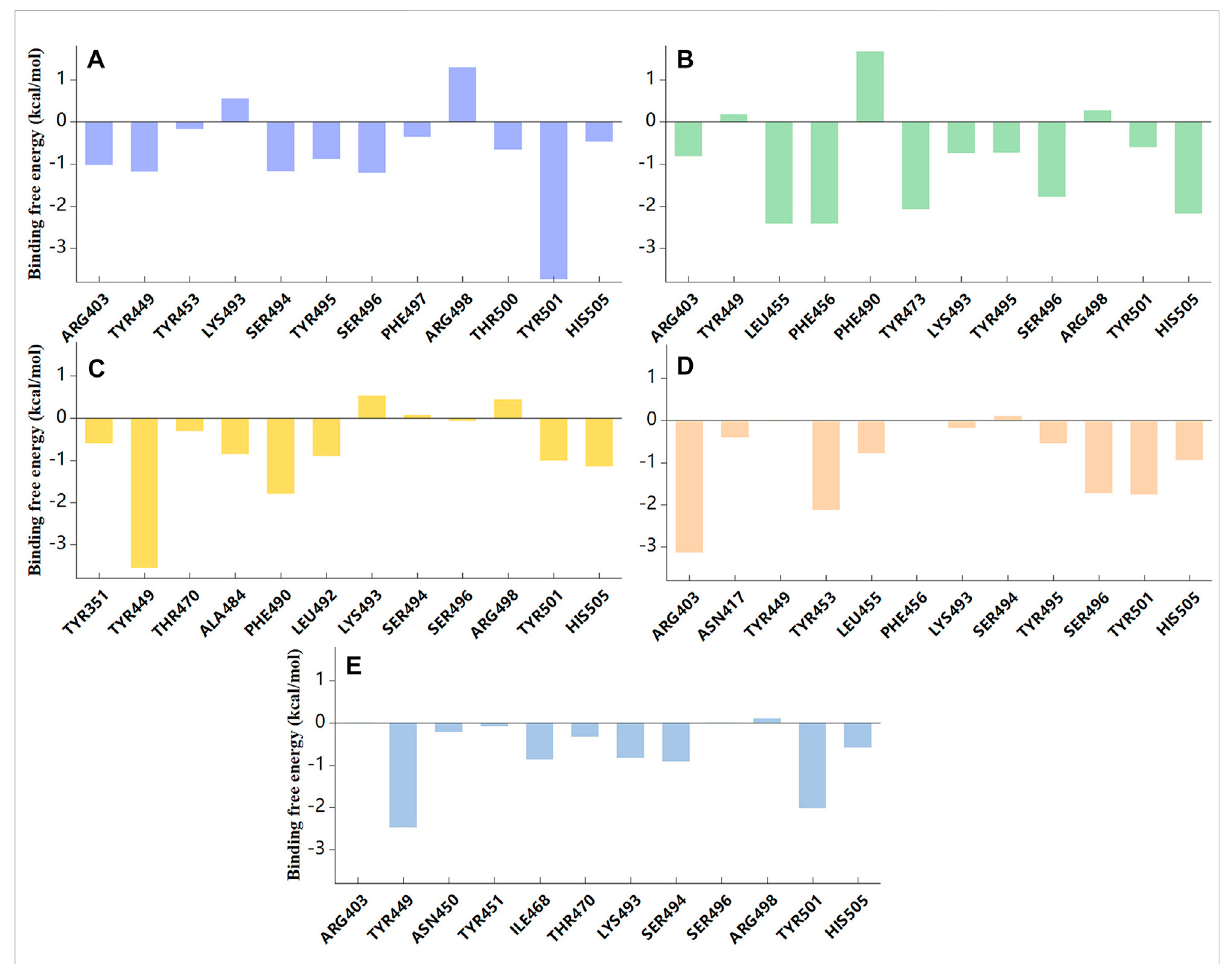
FIGURE 7 Binding free energy contribution of individual residues of RBD protein during 100ns MD simulation. (A) ZINC95919448; (B) ZINC85531210; (C) ZINC95610651; (D) ZINC000035399302; (E)